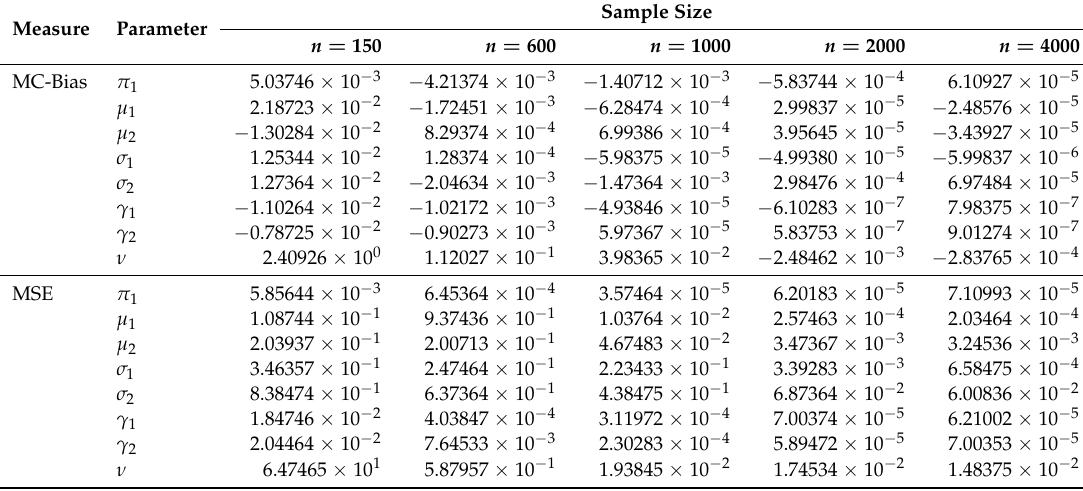
Table 4. MC-Bias and MSE for ML estimates in the medium separated components (MS) FM-TP-T